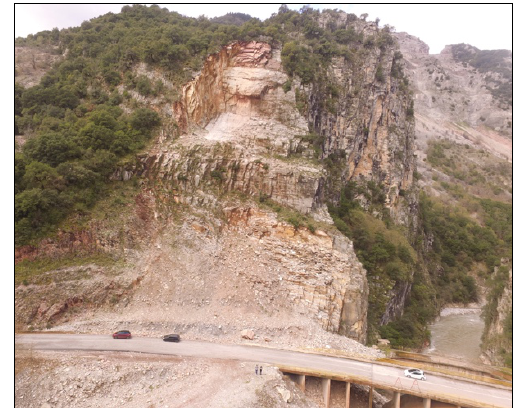
Figure 3. Panoramic view of the landslide case site in Proussos area, Greece